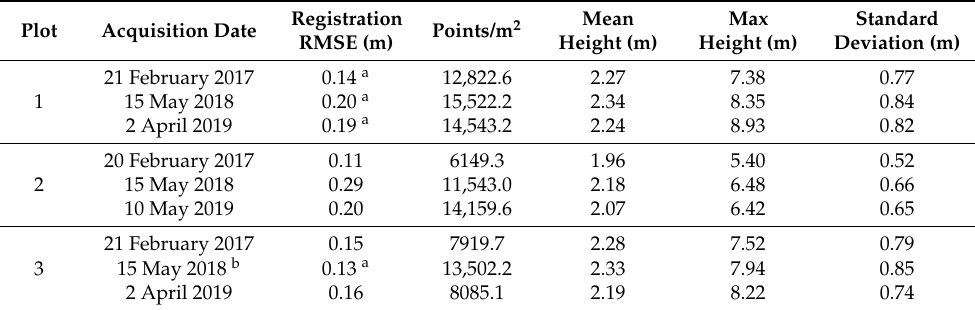
Table 1. Summary statistics of ZEB1 data registration for each of the three monitoring plots over the three monitoring years. Shown for each plot is the scanning date, the registration root mean squared error (RMSE), the mean number of points per square meter, and the mean, maximum, and standard deviation of the individual tree